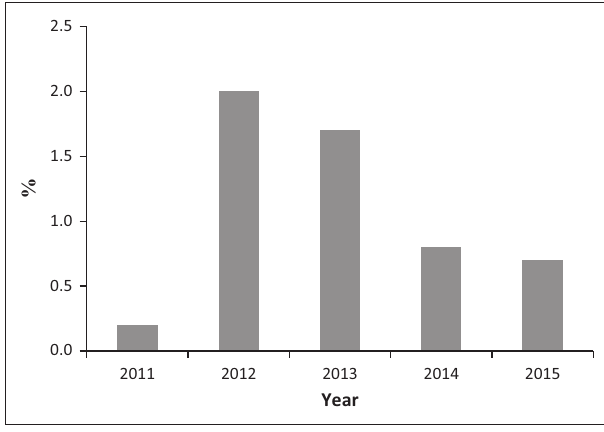
FIGURE 2: Percentage of Leishmania positive IFAT from 2011 – 2015, dogs intended for importation into South Africa.